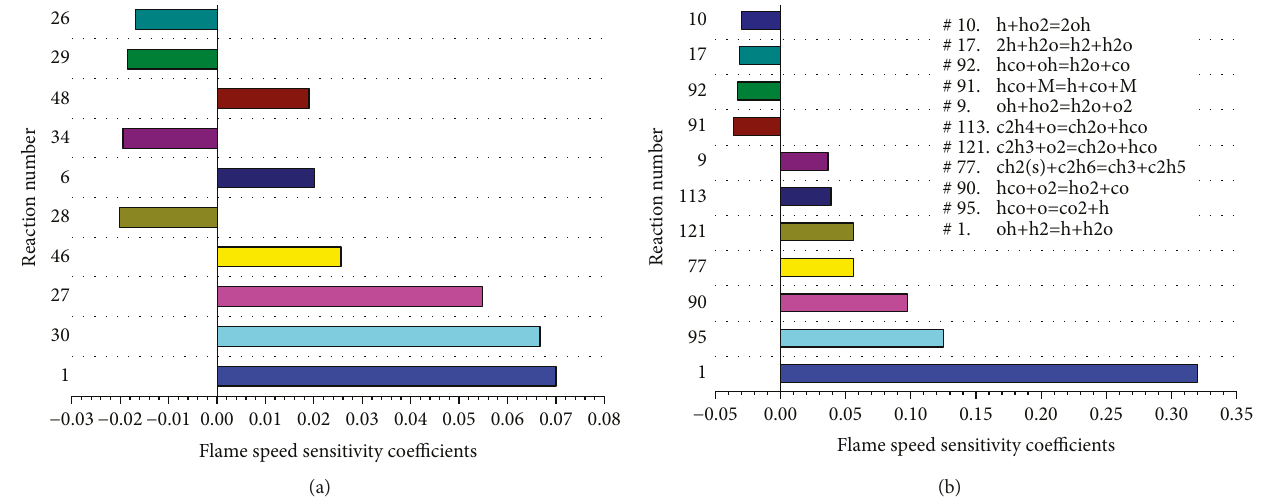
Figure 9: Results of sensitivity analysis to identify important chemical species, (a) reduced mechanism and (b) detailed mechanism.